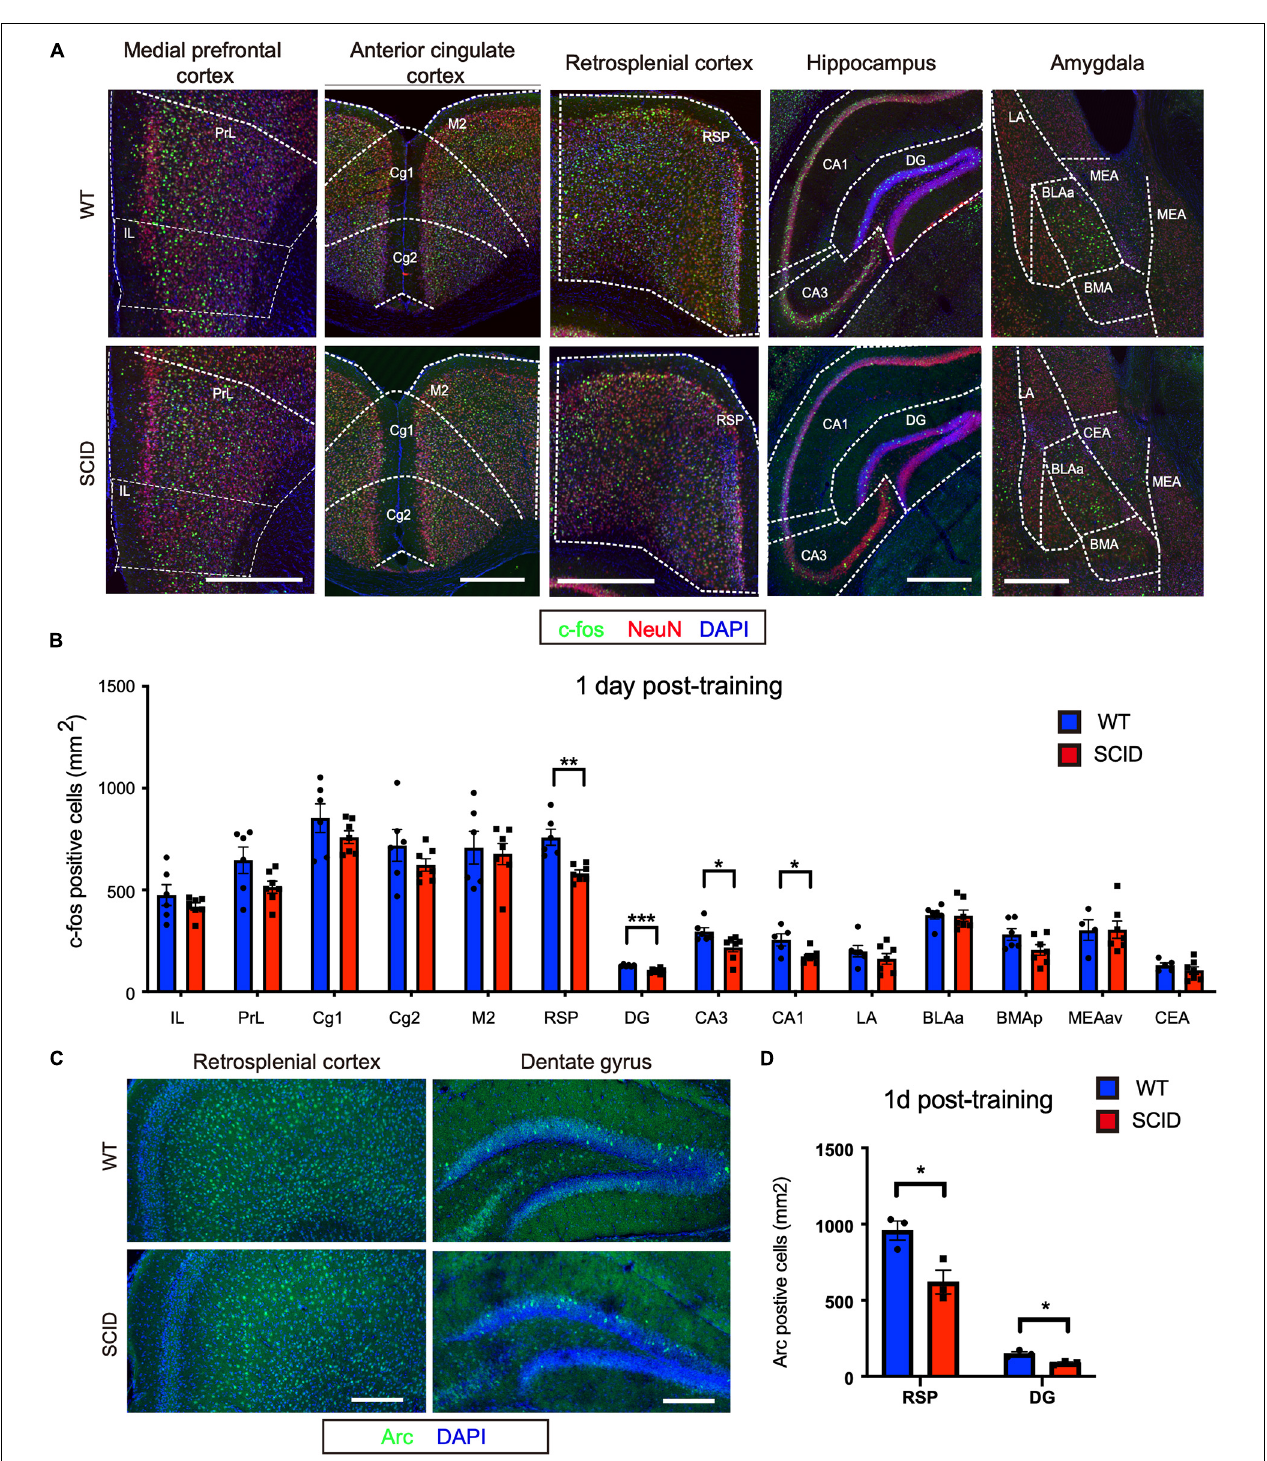
FIGURE 2 | Inefficient neuronal activity in the hippocampus and retrosplenial cortex of SCID mice after recent memory retrieval. (A) Representative immunofluorescence images of five brain regions from WT and SCID mice after recent memory retrieval (1 day after CFC training). c-Fos is in green, NeuN in red, and DAPI in blue. Scale bar, 500 µ m. (B) c-Fos–positive cell density in different brain regions of WT and SCID mice after recent memory retrieval ( n = 6–7 per group, data represent mean ± SEM, * p < 0.05). (C) Representative immunofluorescence images of retrosplenial cortex and dentate gyrus from WT and SCID mice 60 min after recent memory retrieval. Arc is in green, and DAPI in blue. Scale bar, 200 µ m. (D) Quantified Acr-positive cells at RSP and DG regions after recent memory retrieval ( n = 3 per group; data represent mean ± SEM, * p < 0.05, ** p < 0.01, *** p < 0.001).